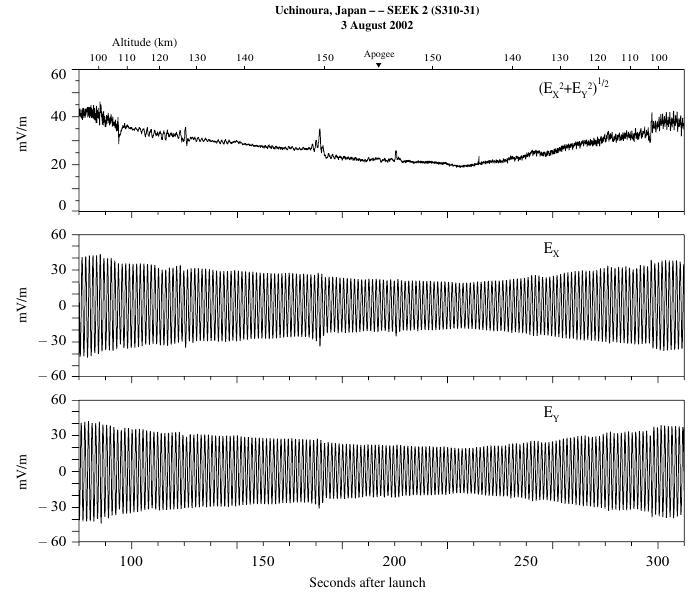
Fig. 4. Raw data from the two perpendicular, spin plane electric field detectors (lower panels). The upper panel is the magnitude of these components.